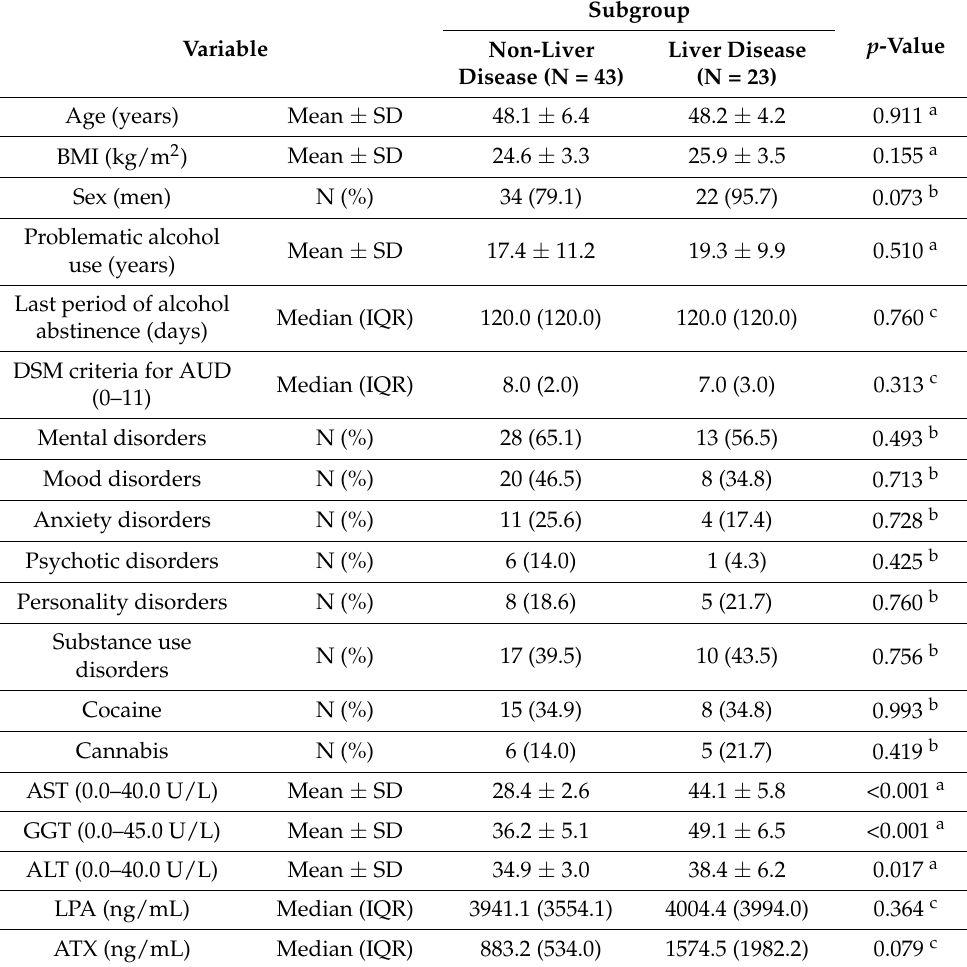
Table 2. Clinical and biological characteristics of the alcohol